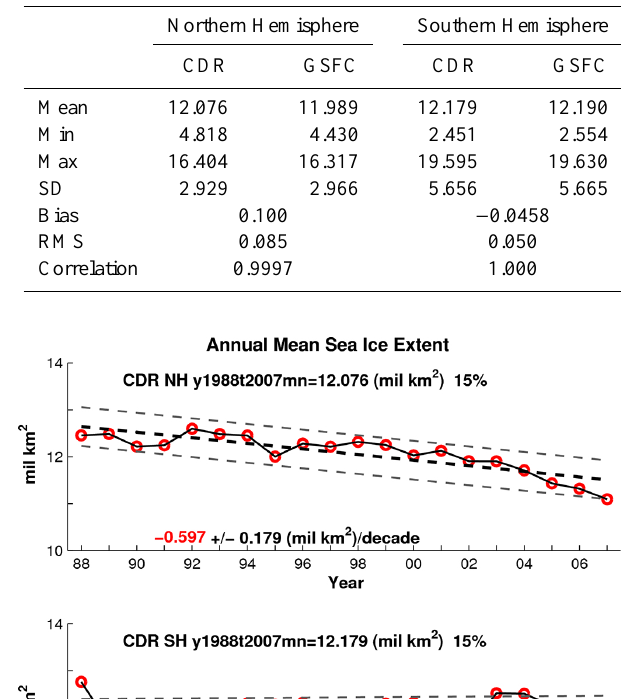
Table 2. The basic statistics of monthly CDR and GSFC sea ice extents (million square kilometers).